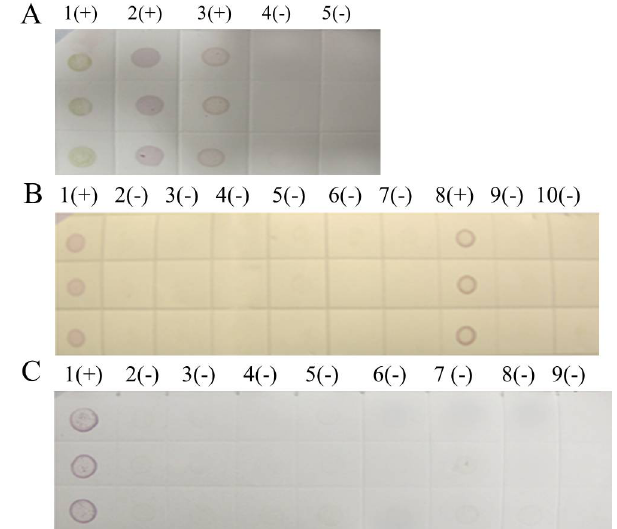
Figure 9. Dot-ELISA test (NC membrane) results of suspected rice plants from Yunnan and Sichuan provinces. (A) 1(+) – 7(+): Kaiyuan, Jinghong, Shizong, Yongshan, Mile, Pingbian and Mengzi respectively. 8(-): Negative control of stem. 9(+): Positive control. (B) 1(+): Positive control. 9(+): Negative control of stem. 2(+) – 10(+): Mengla, Ludian, Gejiu, Yiliang, Fengqing, Shuifu, Zhenxiong, Yanjin. (C) 1(+): Positive control. 9(+): Negative control of stem. 2(+) – 10(+): Maguan, Jiangcheng, Eshan, Kunming, Qiubei, Yuxi, Fushun,